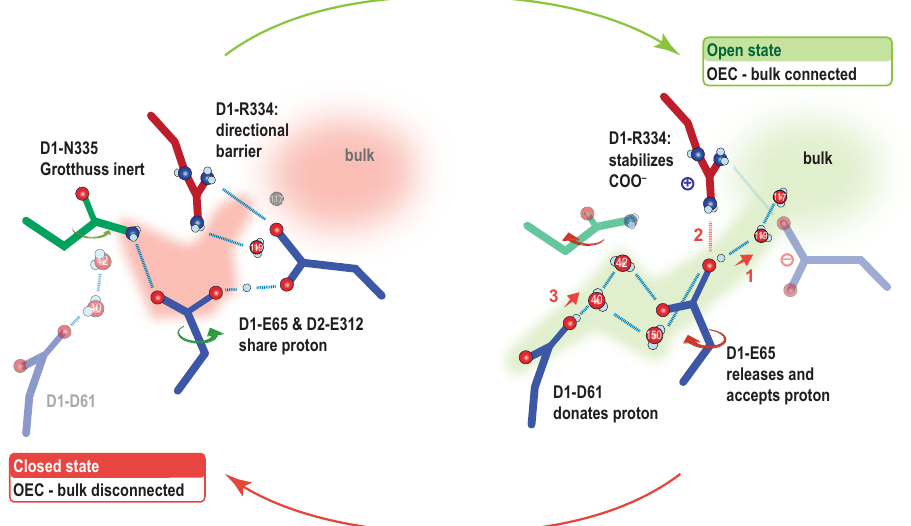
Fig. 6 The proposed proton gate around D1-E65, D2-E312, and D1-R334 in the open and closed state. In the closed state, the H-bonding network connecting the OEC to the bulk is disrupted by D1-N335 and D1-R334, while in the open state, the OEC is connected via D1-E65 and waters to the bulk. The opening of the gate by the rotation of D1-E65 could be caused by the protonation of D1-D61 and the subsequent rearrangement of the H-bonding network. We hypothesized that the proton released towards the bulk was shared between the D1-E65 and D2-E312 before. The deprotonated D1-E65 can then be stabilized by approaching D1-R334. Rotation of D1-E65 back to the original position and closing of the gate may be caused by proton transfer from D1-D61 to D1-E65 and the subsequent repulsion and attraction of the newly arrived proton by D1-R334 and D2-E312,